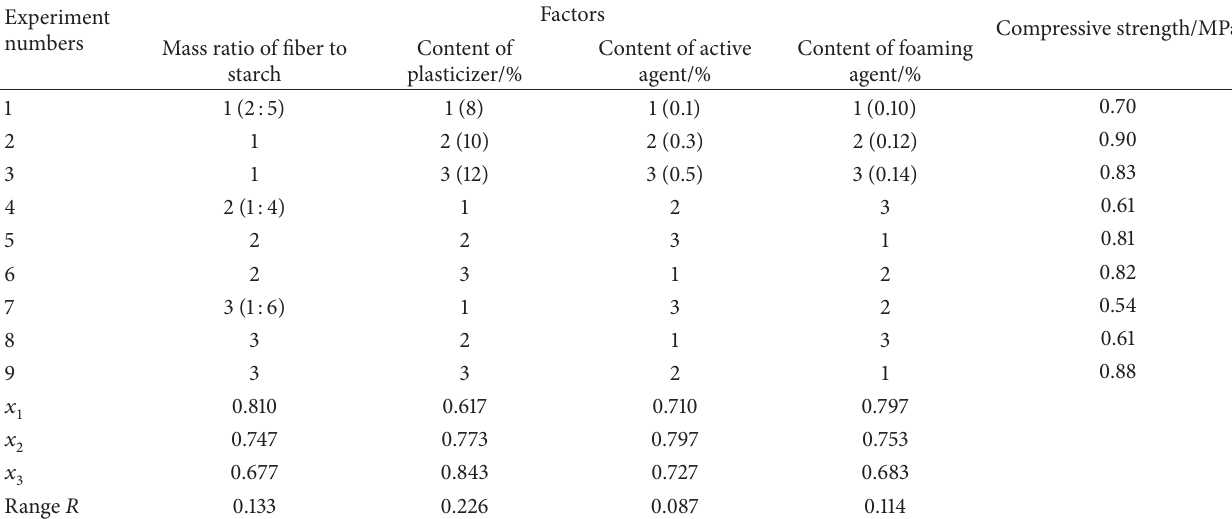
Table 2: Experiment results.